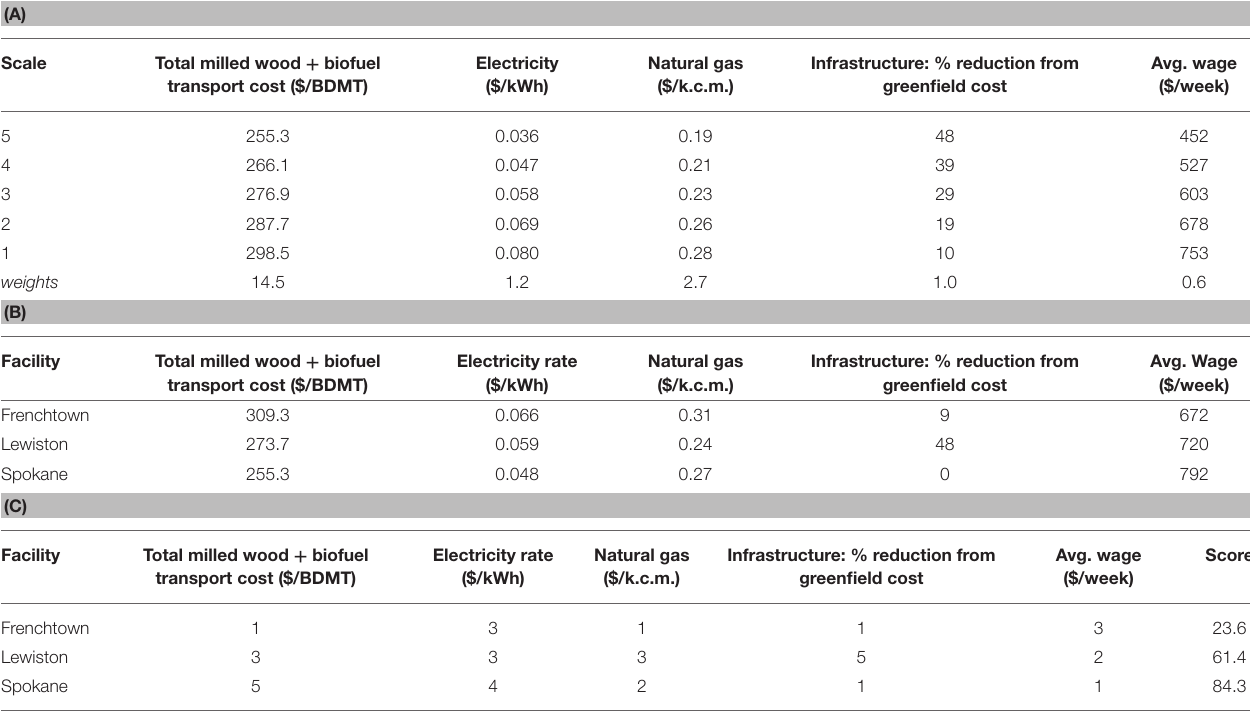
TABLE 8 | (A) Biorefinery decision matrix, (B) Location-specific values, and (C) Scaled values with final facility scores. (A)